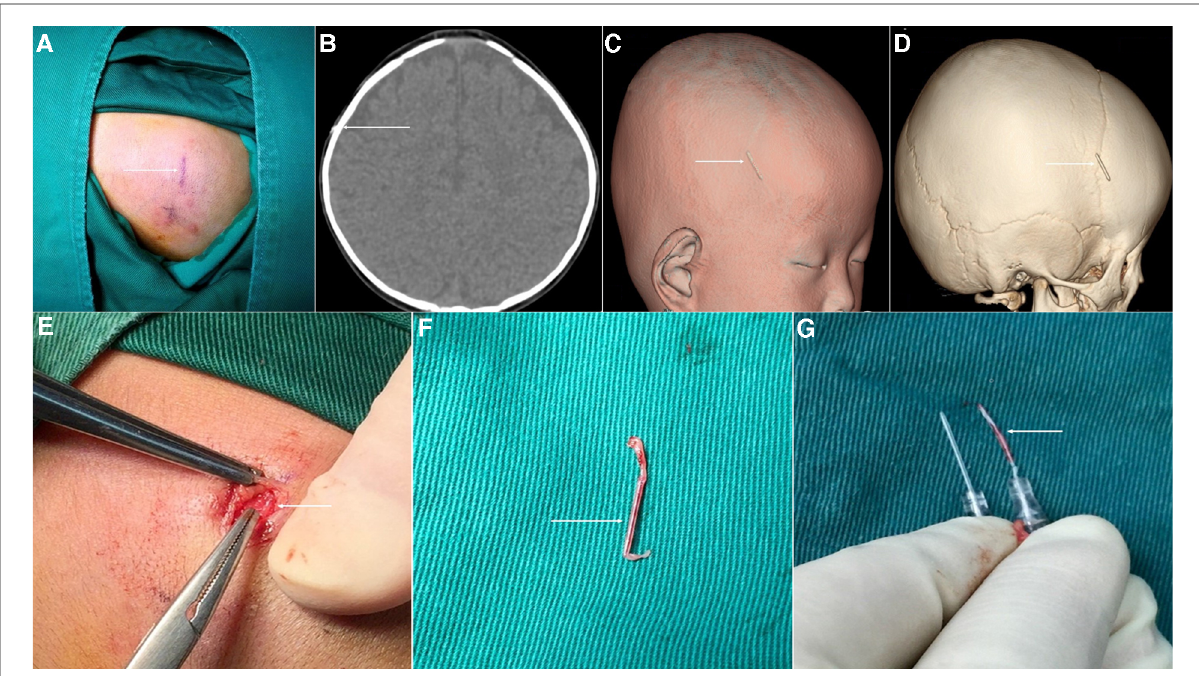
FIGURE 3 Surgical removal of the indwelling needle from the broken scalp vein. ( A ) The local puncture area of the skin near the super fi cial forehead vein is red and swollen with cord-like changes. ( B ) The broken vein indwelling needle is seen as high density on ordinary CT scan. ( C,D ) 3D-CT imaging clearly shows the speci fi c location of the fracture, as well as the surrounding bone markers. ( E ) Blood vessels are seen completely wrapped around the broken indwelling needle. ( F ) The broken catheter was removed successfully during the operation. ( G ) The broken end coincides with the residual needle stem, which is consistent with the length of the normal indwelling